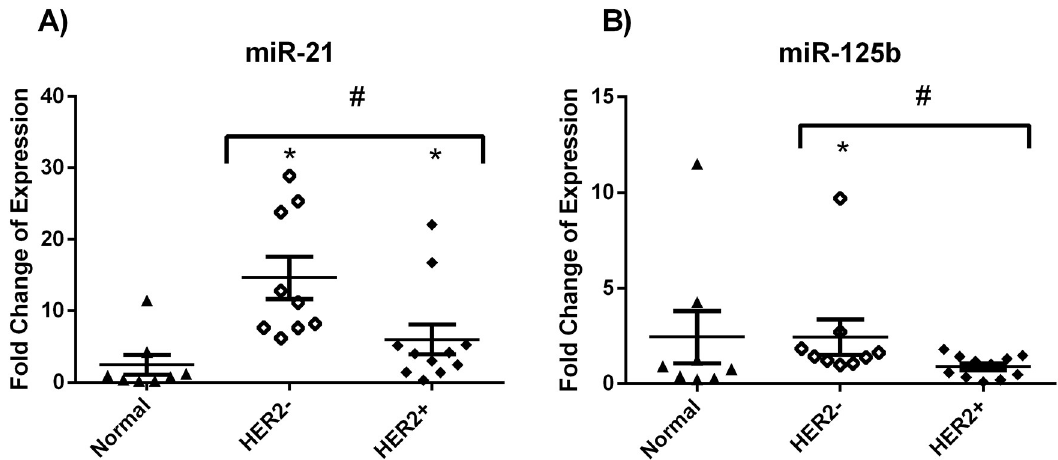
Fig 4. Significant deregulation of miR-21 (A) and miR-125b (B) expression with HER2 status. Dot plots represent the fold change of expression of miR-21 in HER2+, HER2- and normal adjacent tissues. � denotes p < 0.05 for tumor versus normal using Wilcoxon signed rank test. #denotes p < 0.05 using Mann-Whitney test.